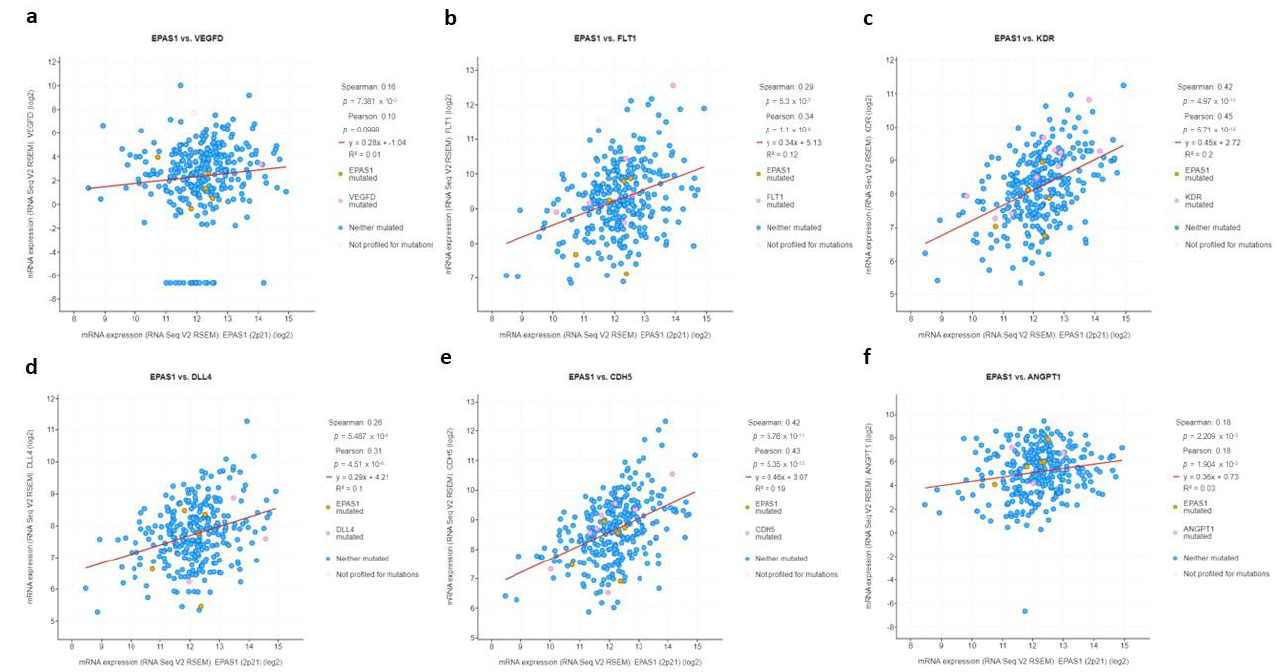
Figure 8. mRNA log2 expression of HIF-2-regulated genes ( a ) VEGFD , ( b ) FLT1 , ( c ) KDR , ( d ) DLL4 , ( e ) CDH5 , ( f ) ANGPT1 in association with EPAS1 expression. ( e ) CDH5 , ( f ) ANGPT1 in association with EPAS1 expression.